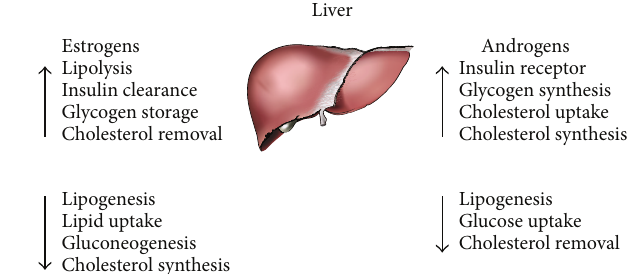
Figure 2: Metabolic effects of estrogens and androgens on regula- tion of lipid, glucose, and cholesterol in the